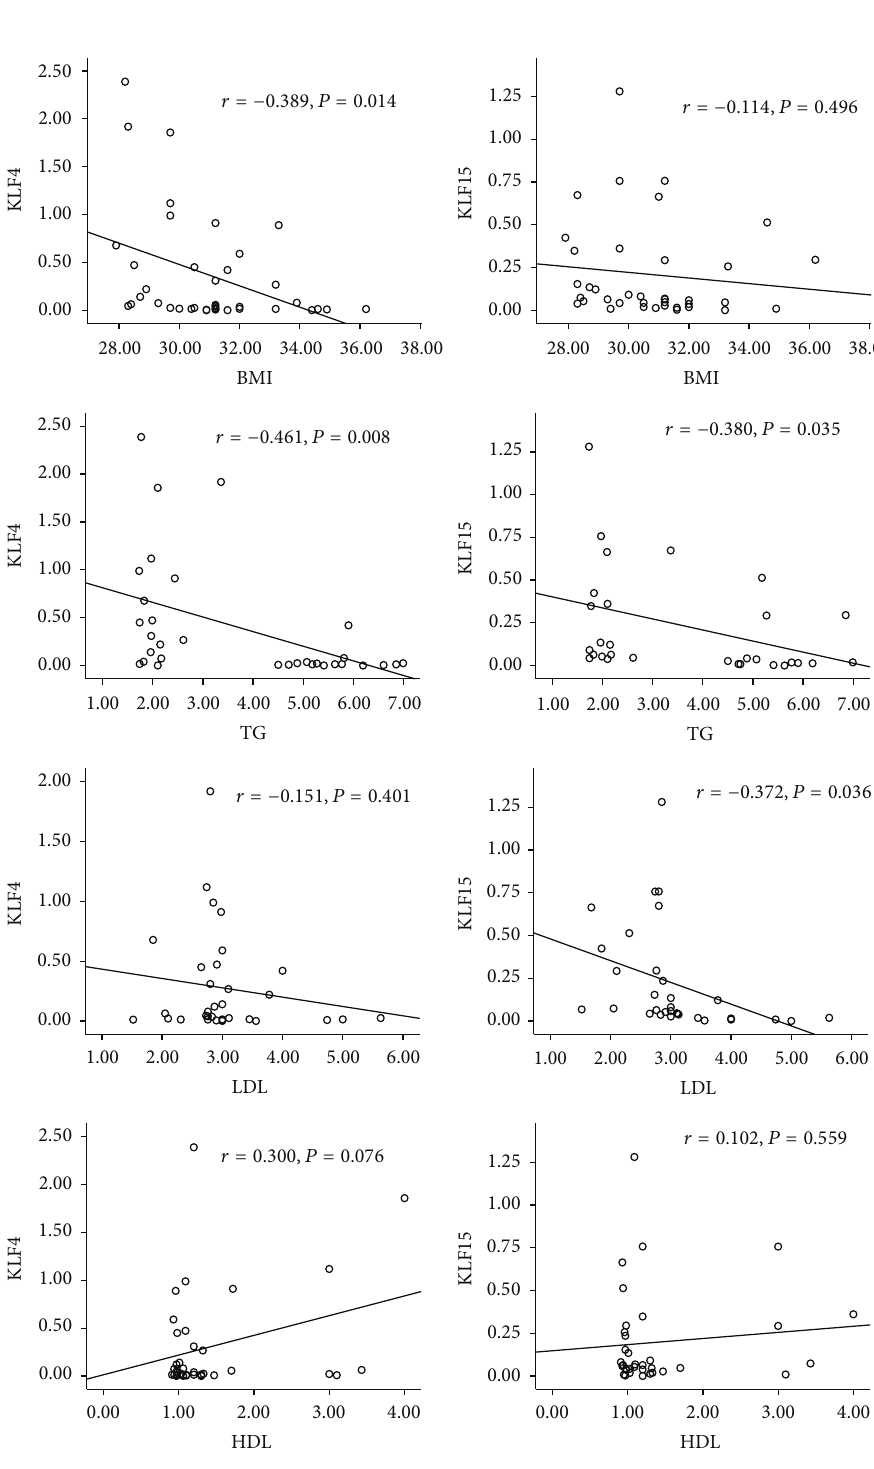
Figure 2: The correlation of the KLF4 , KLF15, and dyslipidemia indexes. Pearson analysis, 𝑃 < 0.05 . The correlation between the two groups has statistical